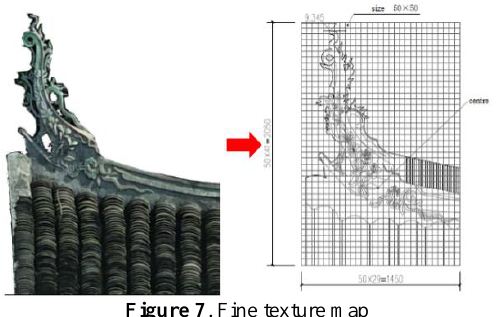
Figure 7 . Fine texture map